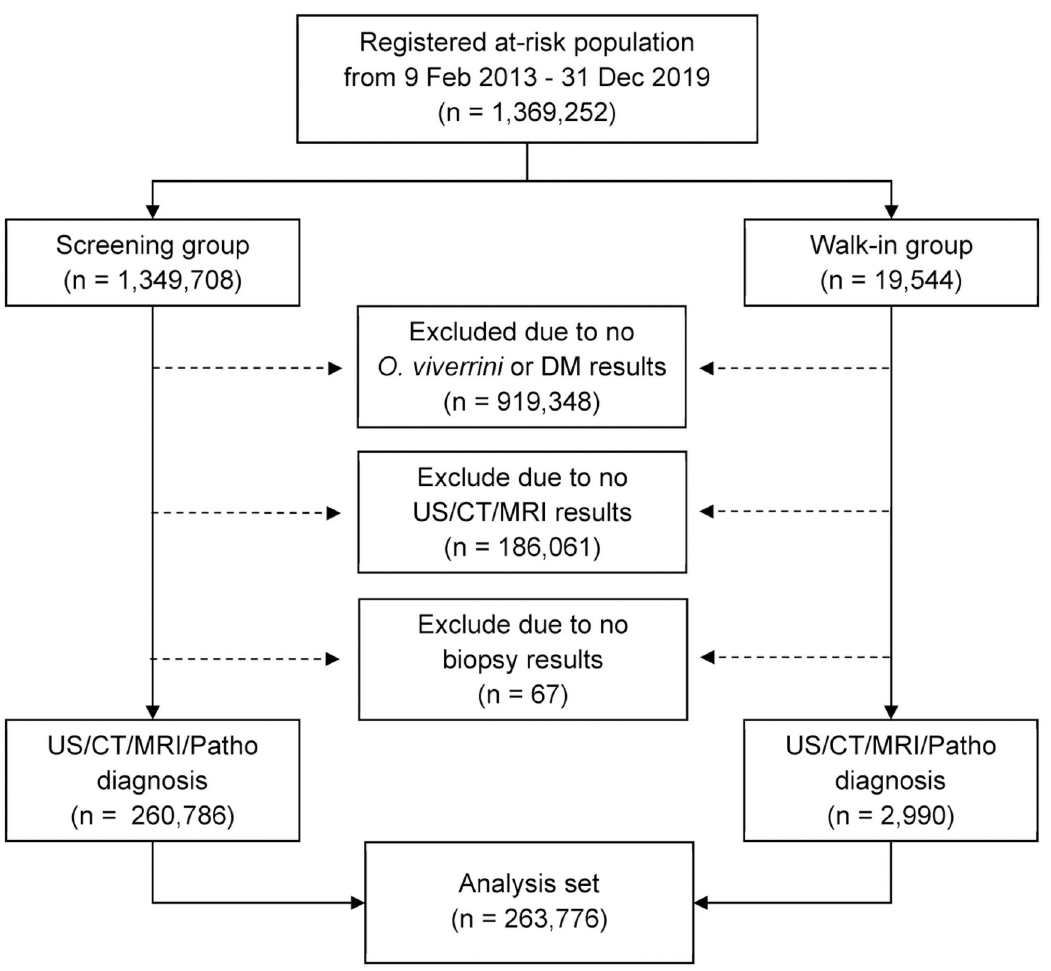
Fig 1. Data selection process. Flowchart showing the number of participants at each stage of data selection, leading to the final analysis set.